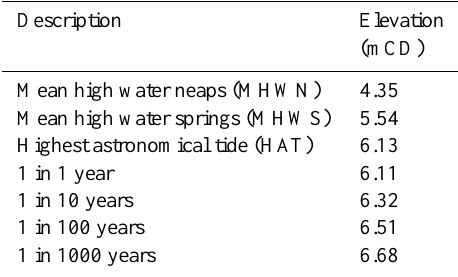
Table 1b. Sea levels at Newlyn (to base year of